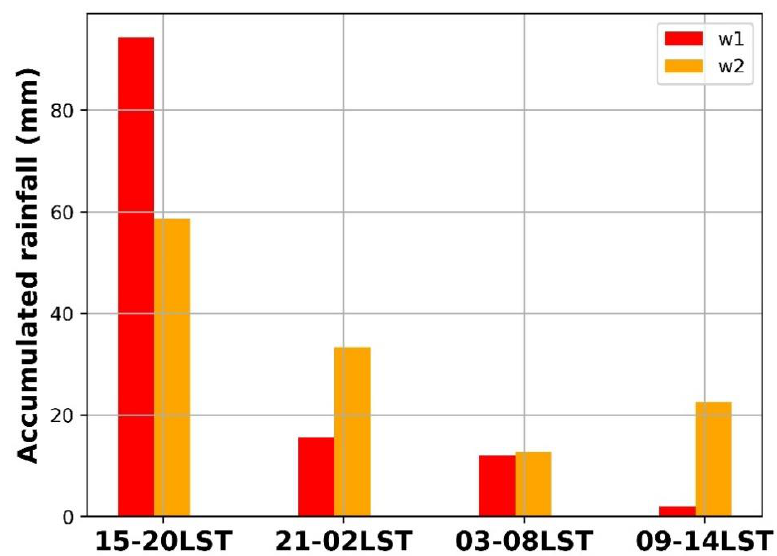
Figure 10. Diurnal cycle of accumulated rainfall from events that contain convective rainfall for two rainy seasons (12 months). W1: season 2017–2018 and W2: rainy seasons (12 months). W1: season 2017 – 2018 and W2: 2018 – 2019.